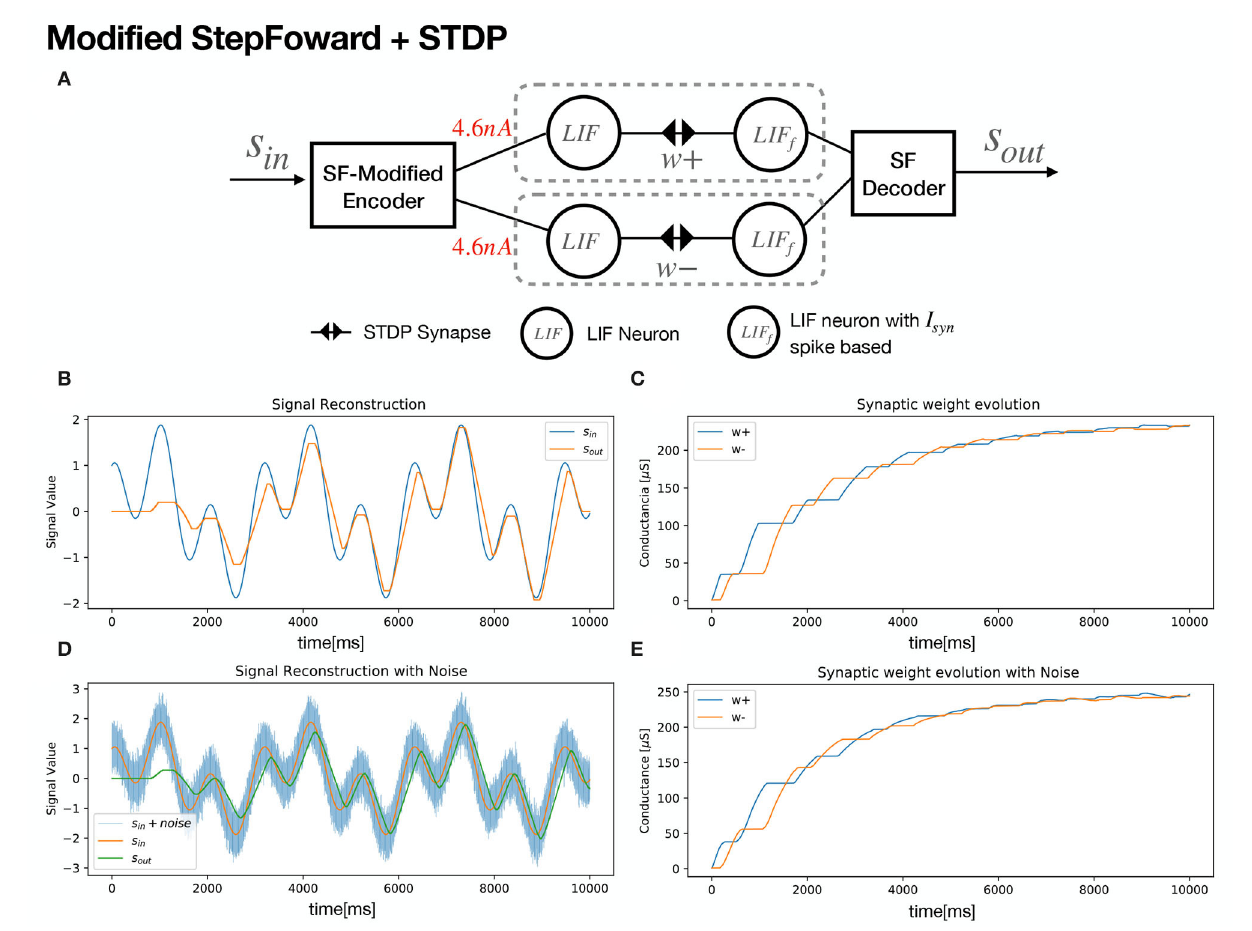
FIGURE 3 | Modified Step Forward + STDP Neural structure. (A) Schematic of the structure. (B) Sinusoidal Signal s in = sin( ω t ) + cos(3 ω t ) being reconstructed. (C) Synaptic Weight evolution. (D) Gaussian noise with σ = 0.3 was added to foster synaptic update. (E) Synaptic Weight evolution with added noise. Simulation parameters are available at Table 3 .